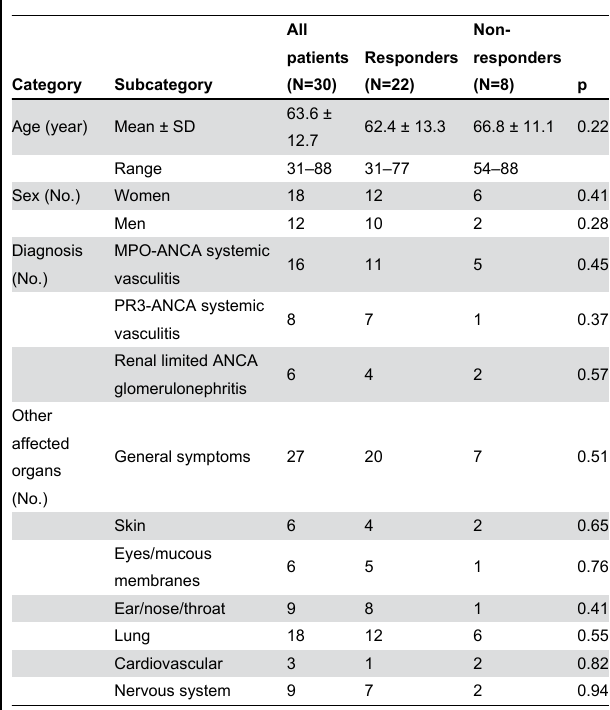
Table 1. Demographic and clinical characteristics of patients with ANCA-associated glomerulonephritis in all patients, in responders and in non-responders at the time of